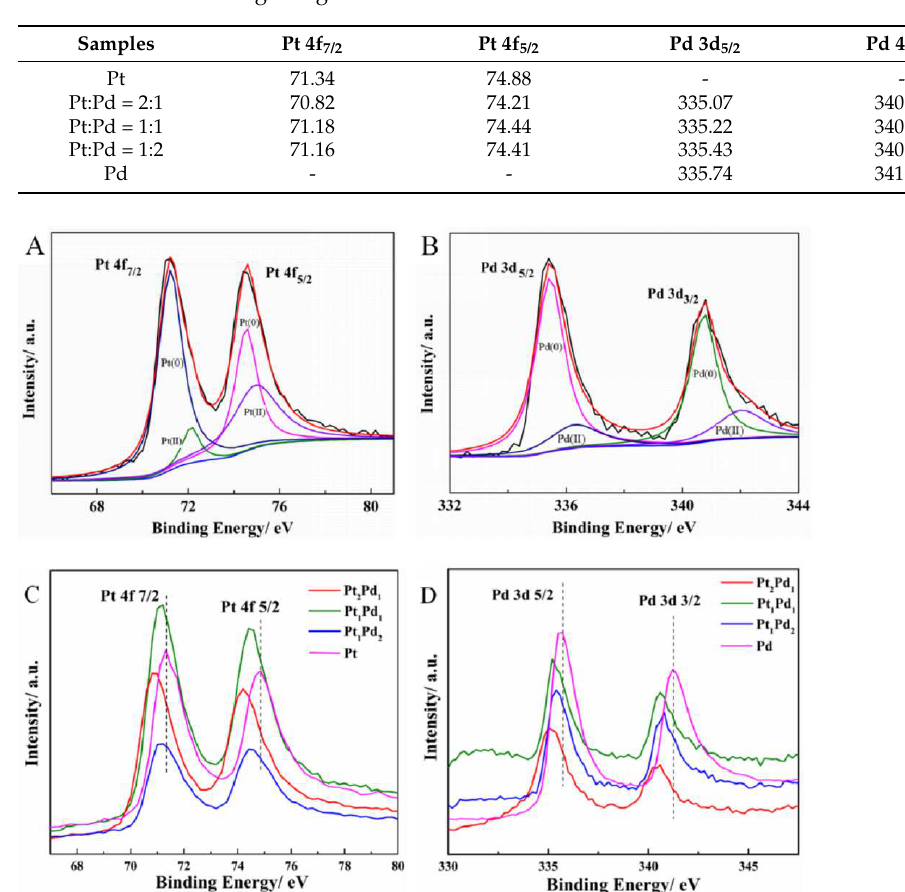
Figure 3. XPS spectra of ( A ) Pt 4f, ( B ) Pd 3d of Pt 1 Pd 2 NCs; and ( C ) Pt 4f; (D ) Pd 3d of Pt NCs, Pt2Pd1 NCs, Pt1Pd1 NCs, Pt1Pd2 NCs, and Pd NCs.